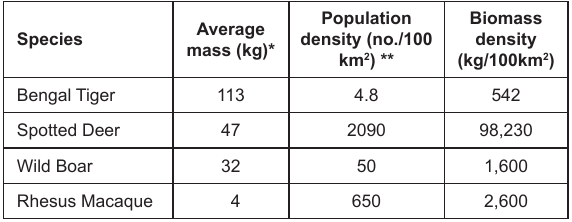
Table 3. Individual density and biomass density of tigers and potential prey in the Sundarbans East Wildlife Sanctuary Species